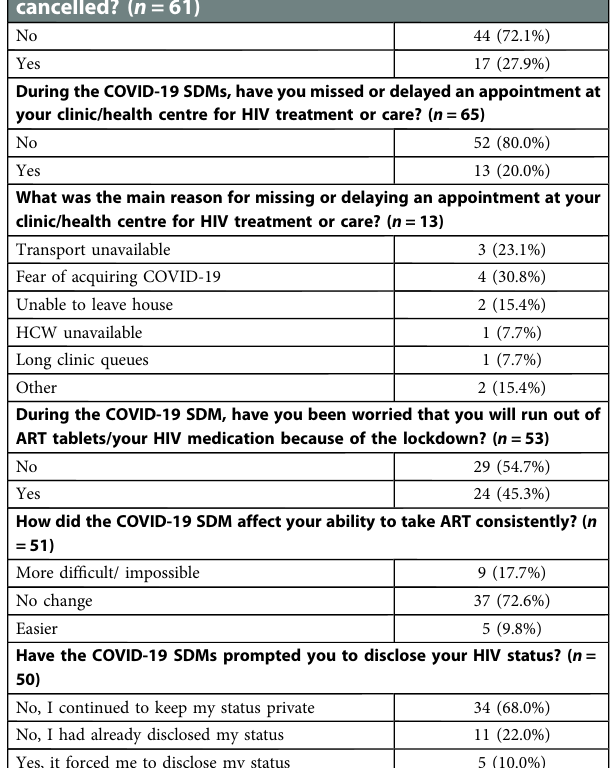
TABLE 3 The impact of COVID-19 social distancing measures on access to essential HIV treatment and services for PLWH responding to the Botswana I-SHARE